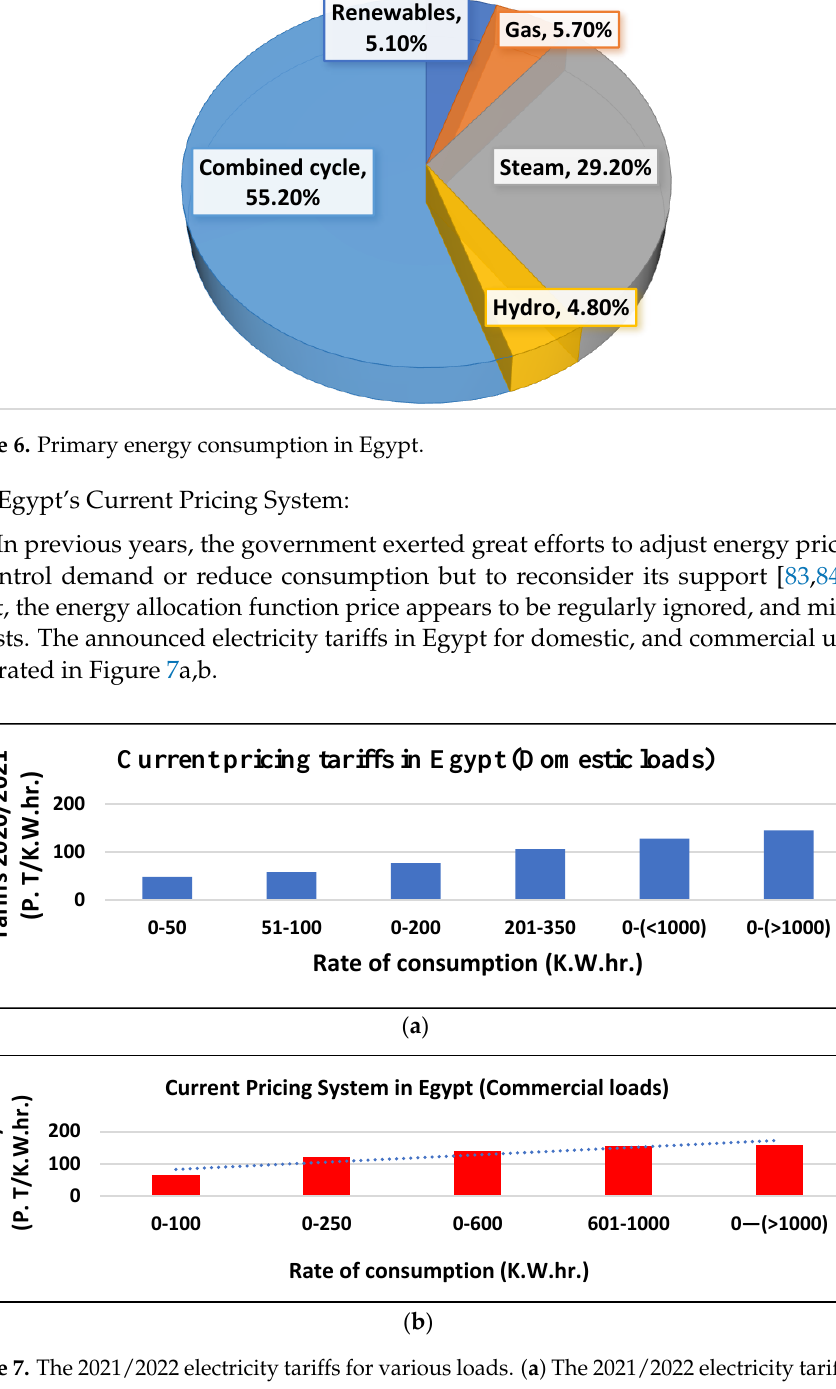
Figure 8. Feed-in tariff values for solar energy resources in Egypt. The drawbacks of the current set tariffs in Egypt: The cost of electricity is significantly less than the actual economic price of both sup- ply and generation. These low prices increase the energy waste and the instability in de- mand, resulting in increasing the power generation capacity [84,85]. According to the “Electric rate” electricity pricing in 2022, Egypt is among the least expensive prices among the different countries. The price of electricity is 0.042 U.S. dollars per kWh for domestic loads and 0.058 U.S. dollars for commercial ones. If this pricing is compared to that in other countries, we can recognize that the average electricity price in the world is 0.139 U.S. dollars per kWh for domestic loads and 0.134 U.S. dollars for com- mercial loads for that period. This also emphasizes that the electricity tariff mispricing problem persists despite the tariffs having been raised in the last few years. Egypt’s electricity sector has faced many problems since 2009, such as inefficient mo- nopolies, high power losses, increasing operating costs, unnecessary investments, and